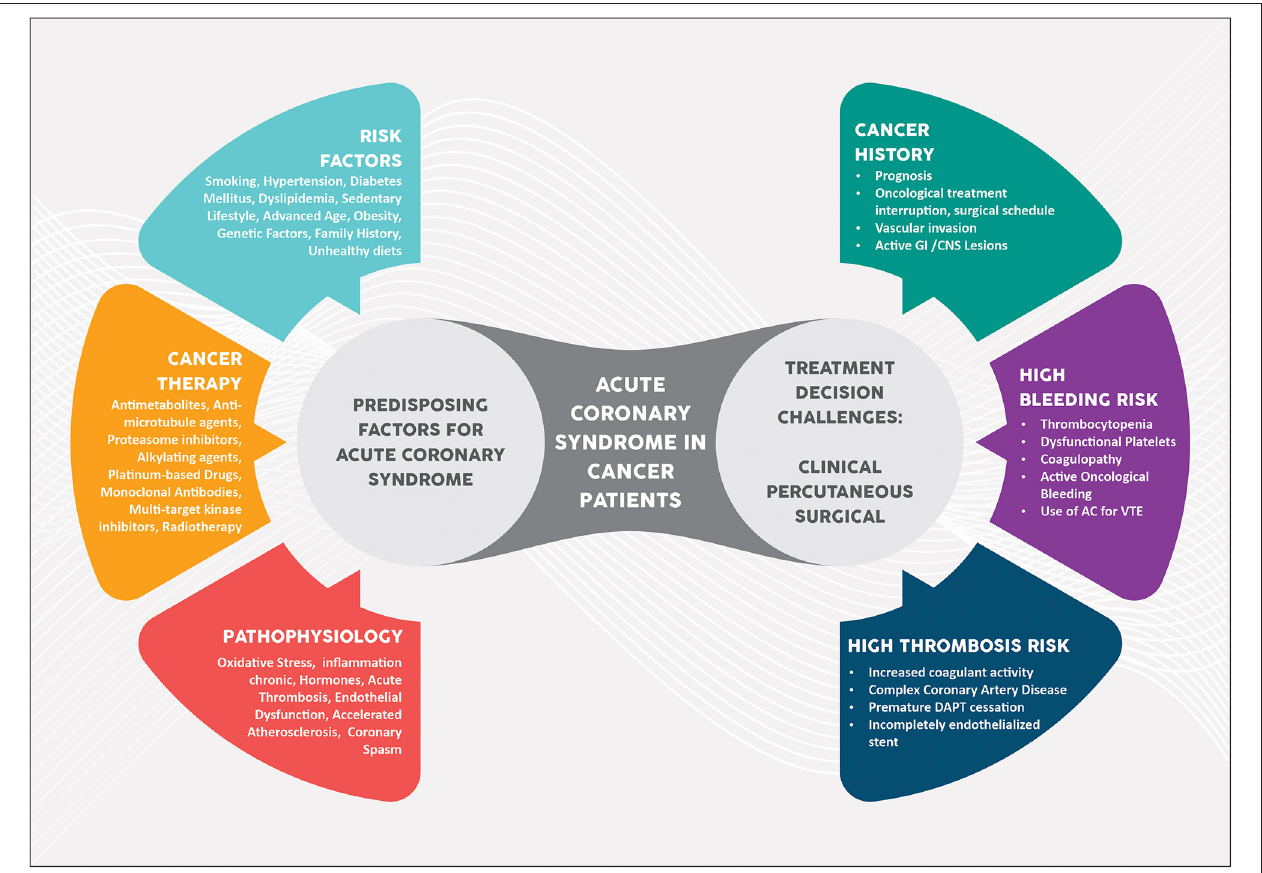
FIGURE 1 | Central illustration. Acute coronary syndrome in cancer patients. AC, anticoagulation; CNS, central nervous system; DAPT, dual antiplatelet therapy, GI, gastrointestinal; VTE, venous